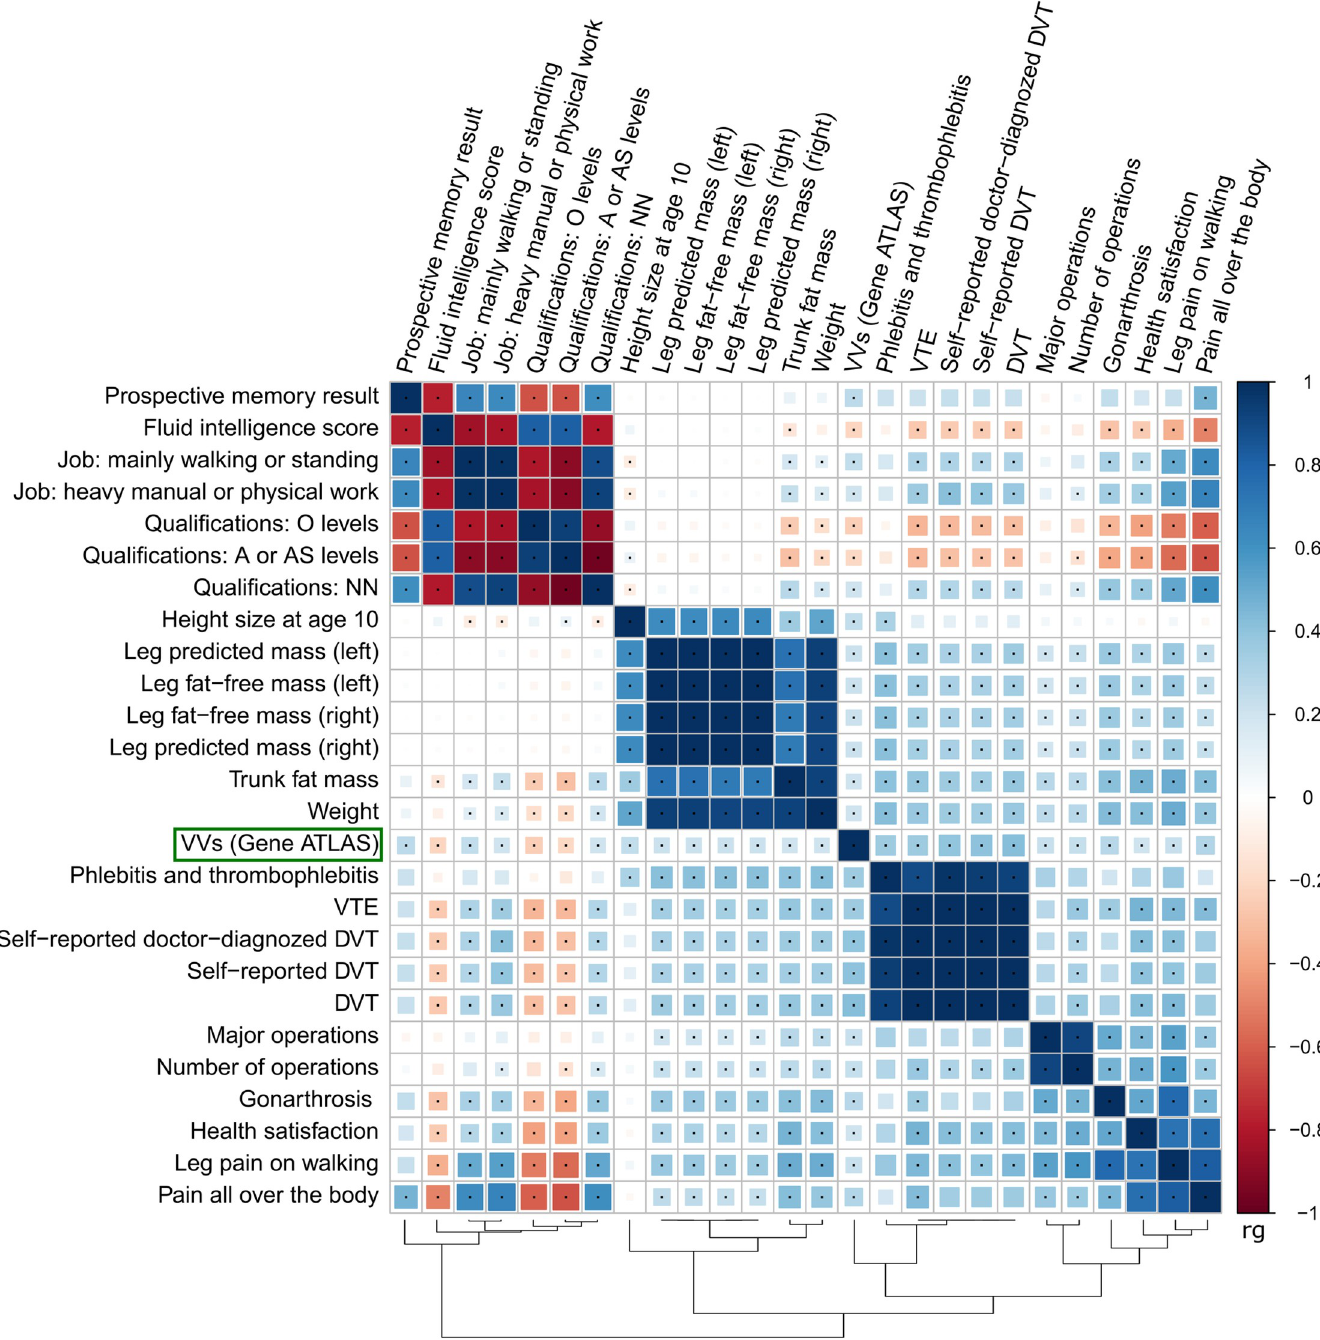
PLOS Genetics | https://doi.org/10.1371/journal.pgen.1008110 April 18,